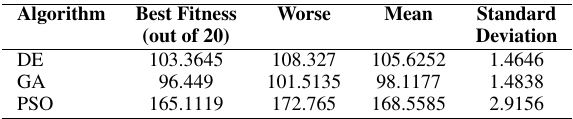
TABLE 5: Comparative performance of DE, GA, PSO and